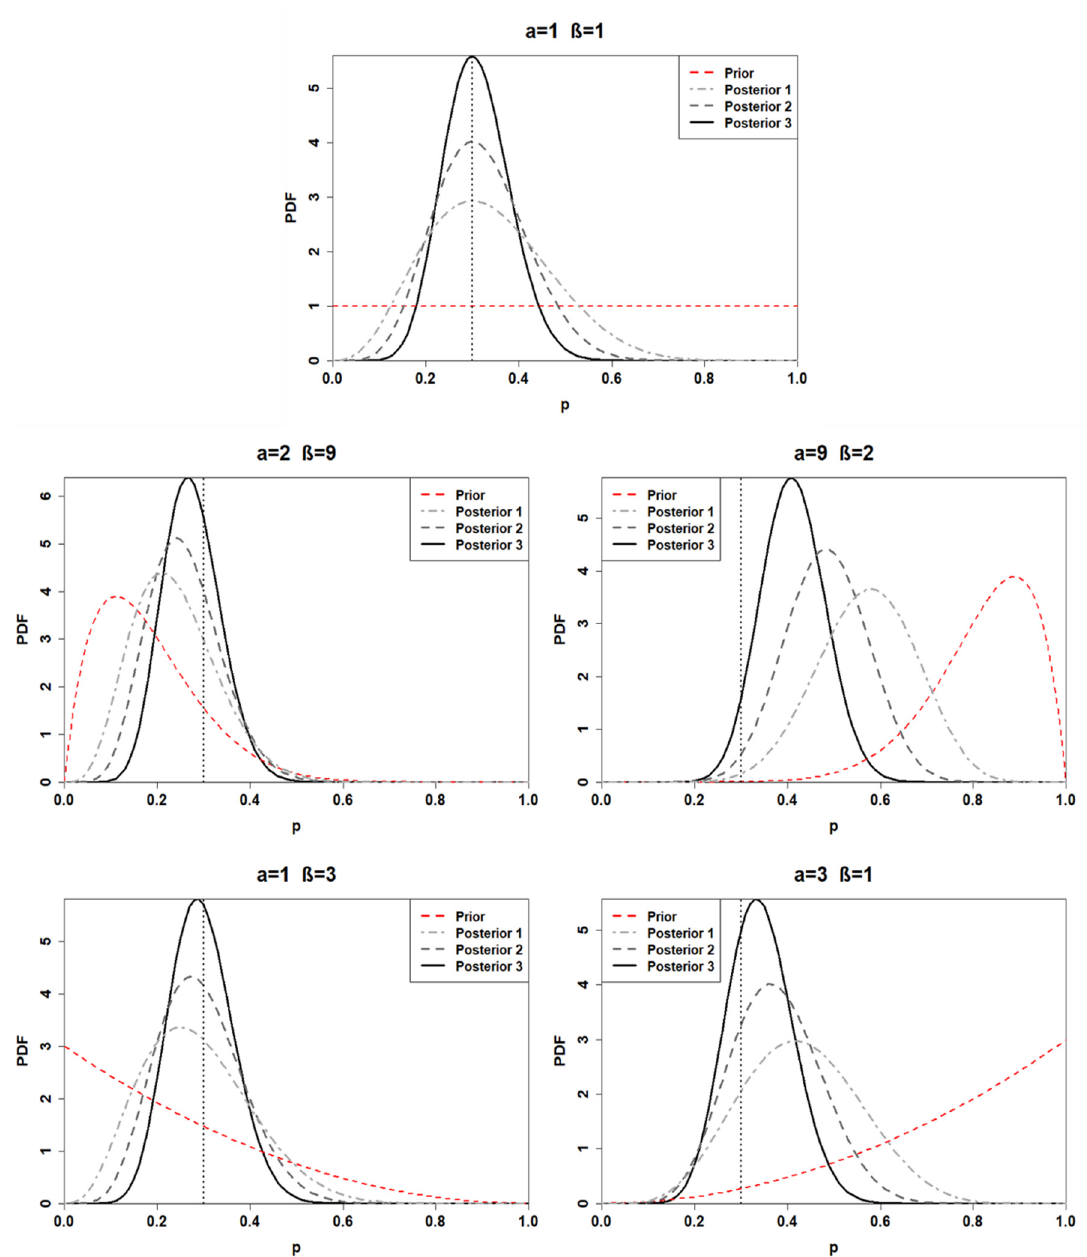
Figure 5. Developed posterior distributions for each choice of prior, which is identified by the values of α and β above each graph. Posterior 1, Posterior 2, and Posterior 3 denote the posterior distributions obtained for the first, second, and third applications. At last, the vertical dotted line represents the likelihood means.